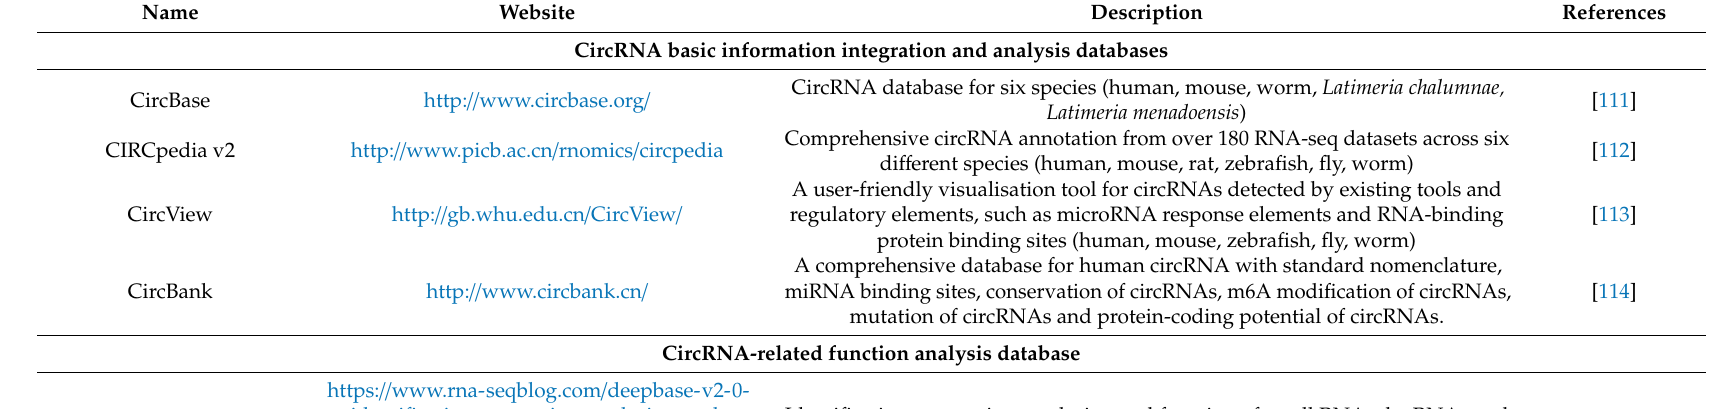
Table 6. Human disease circRNA-related